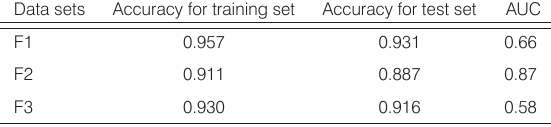
model.Data Table 2. Results of prediction models using random Figure 2. Accuracy curve of the training set and the test set of the F1